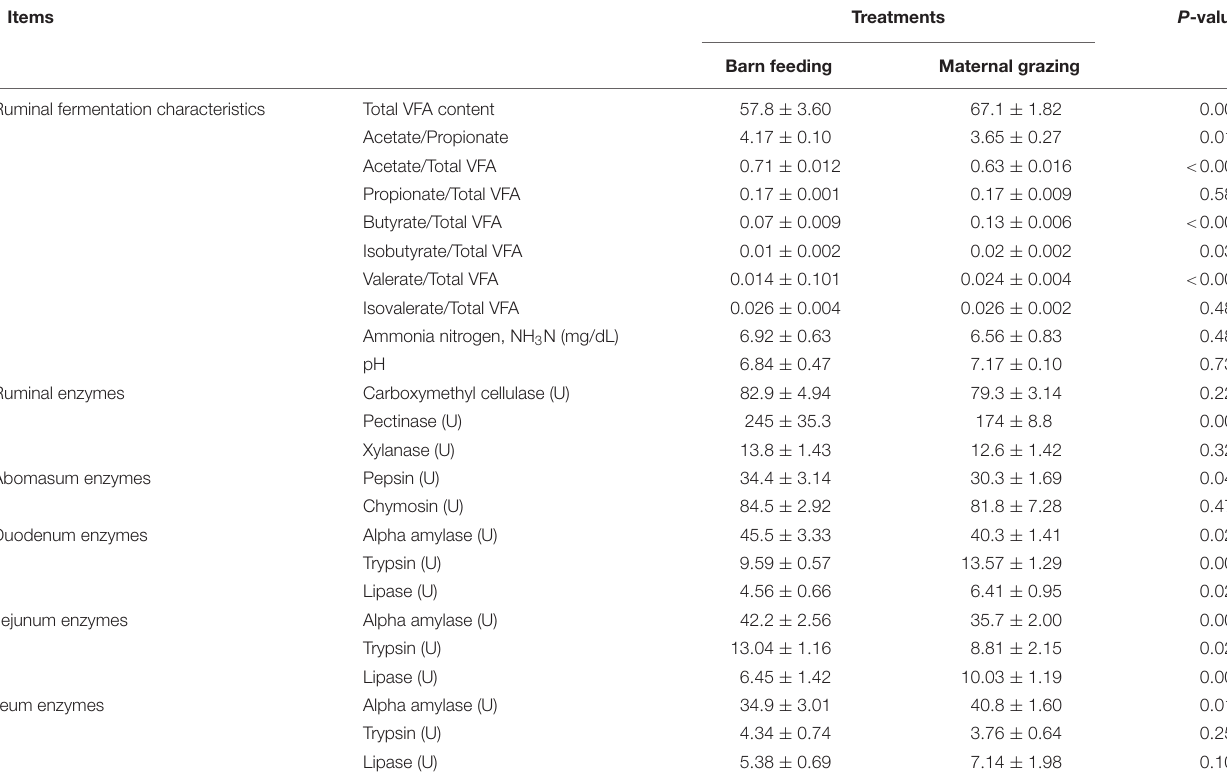
TABLE 2 | Effects of two feeding strategies (maternal grazing and barn feeding) during early life on the ruminal fermentation characteristics, as well as the ruminal, abomasum, and intestinal enzyme activities of yak calves.